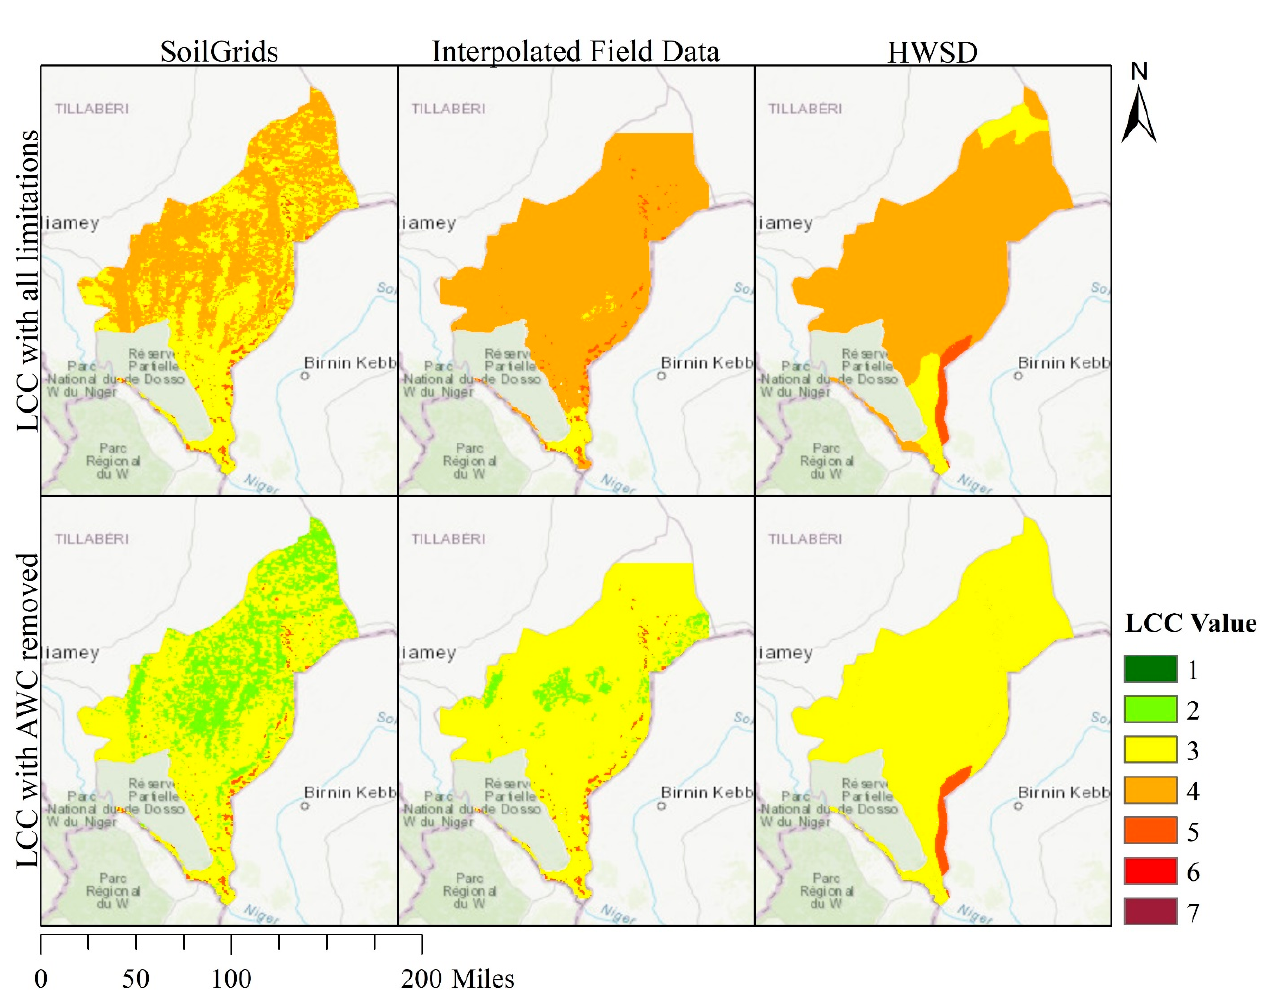
Figure 5. Land capability classification (LCC) maps for SoilGrids, field data, and Harmonized World Soil Database (HWSD). LCC ranges from 1 to 8 and is calculated on a per pixel